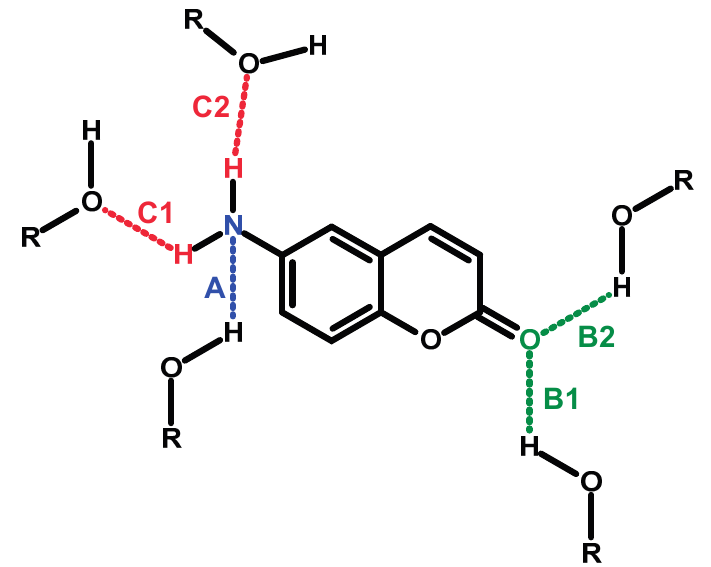
Figure 1. Illustration of different types of intermolecular hydrogen bonds between 6-aminocoumarin (6AC) and solvent